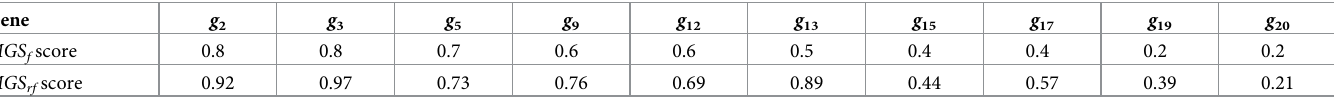
) and importance score ( MGS f